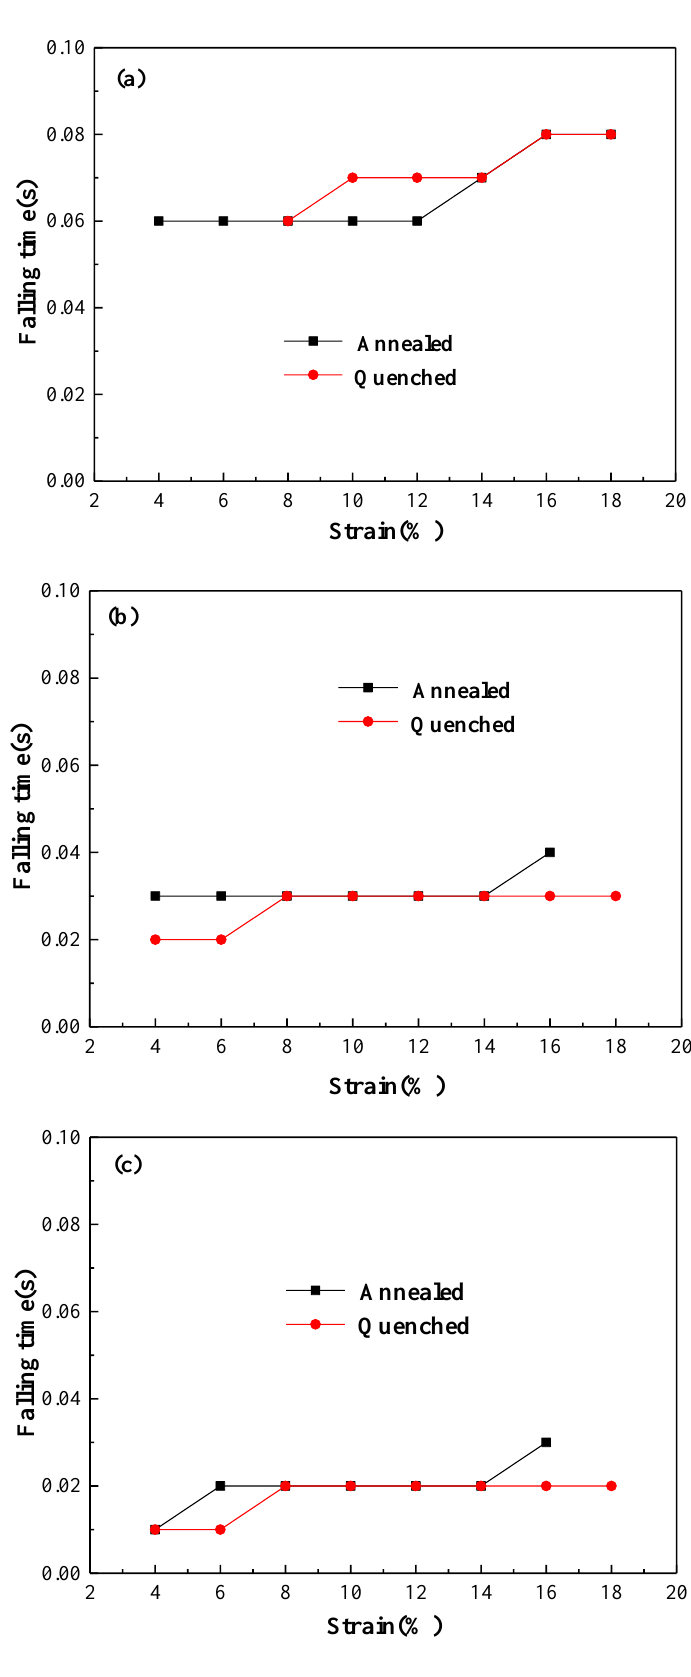
Figure 12. The falling time (t d ) of the annealed and quenched 5083 Al alloy sheets at different strain rates: ( a ) 1 × 10 − 4 s − 1 ; ( b ) 1 × 10 − 3 s − 1 ; and ( c ) 1 × 10 − 2 s − 1